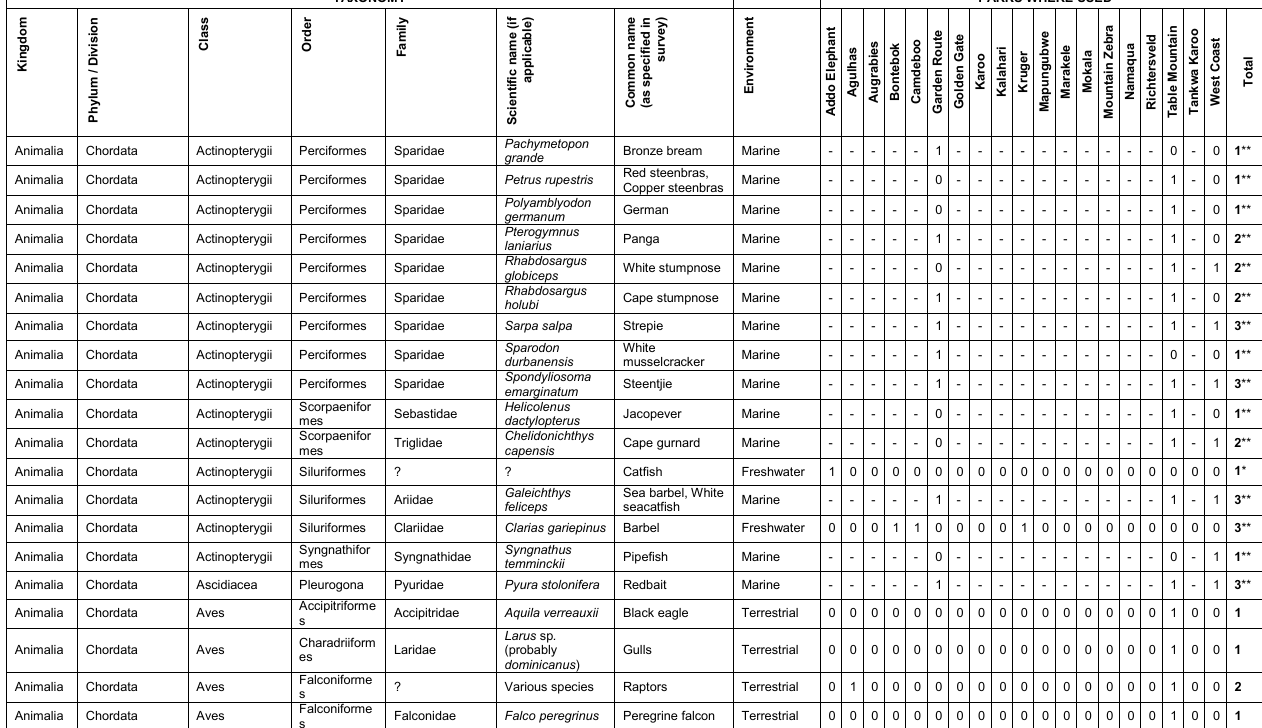
Gulls Terrestrial 0 0 0 0 0 0 0 0 0 0 0 0 0 0 0 0 1 0 0 1 dominicanus ) Animalia Chordata Aves Falconiforme s ? Various species Raptors Terrestrial 0 1 0 0 0 0 0 0 0 0 0 0 0 0 0 0 1 0 0 2 Animalia Chordata Aves Falconiforme s Falconidae Falco peregrinus Peregrine falcon